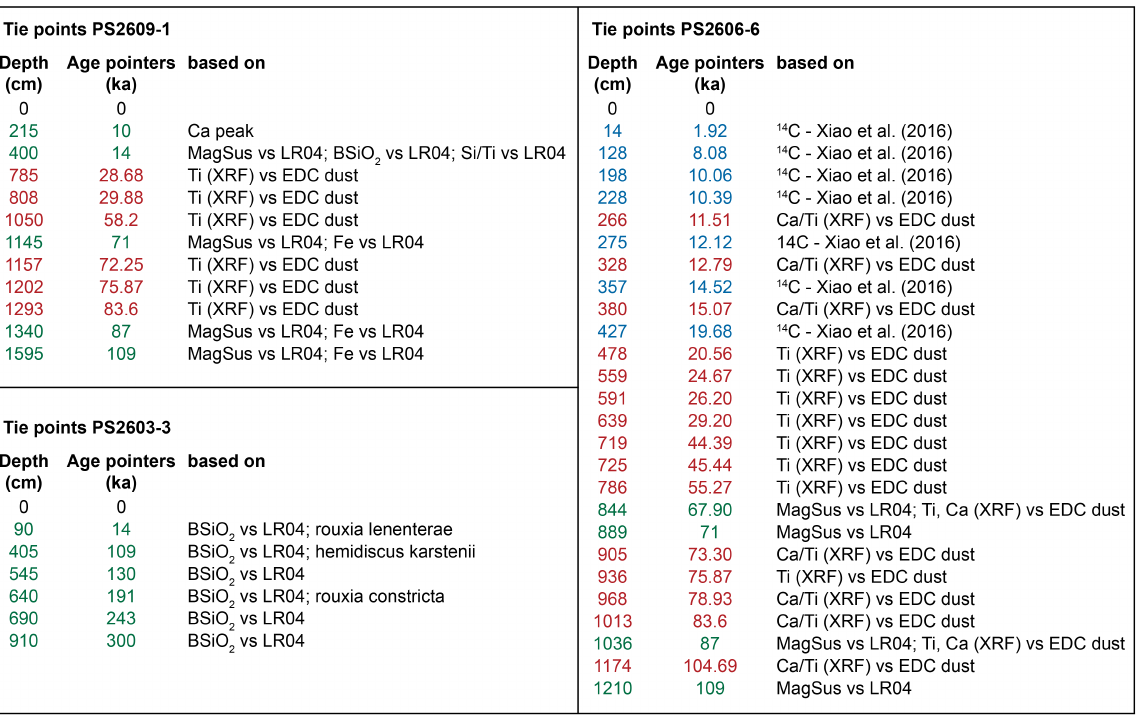
Table 1. Tie points of cores PS2609-1, PS2606-6, and PS2603-3. MagSus stands for magnetic susceptibility, BSiO 2 stands for biogenic silica, LR04 is the global benthic δ 18 O LR04 stack (Lisiecki and Raymo, 2005), and EDC is Epica Dome C (Lambert et al.,